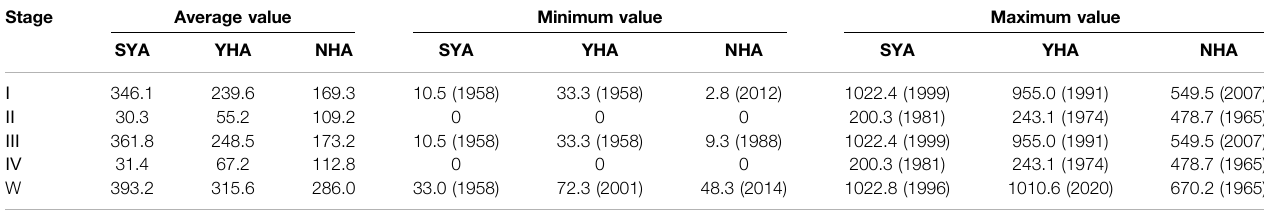
TABLE 2 | Statistical characteristics of precipitation in SYA, YHA, and NHA during 1957 – 2020 over Meiyu and Huang-Huai rainy seasons.